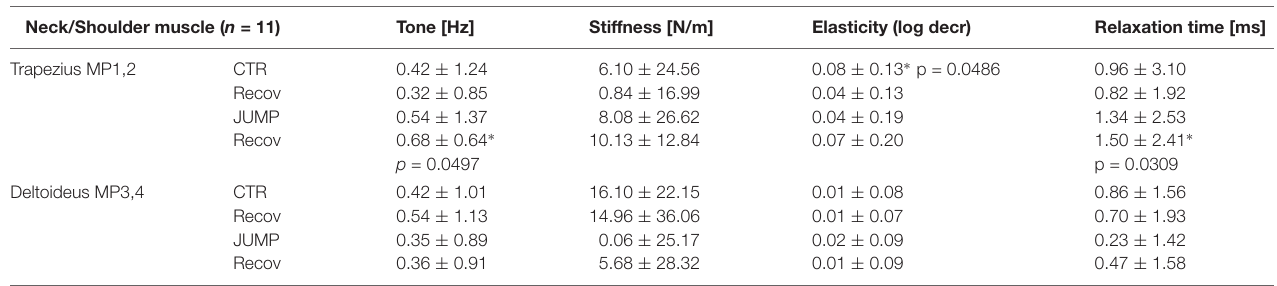
Biomechanical data collected from neck and shoulder muscle skin measurement points (Trapezius MP1,2 and Deltoideus MP3,4) in bed rest (HDT + 59 vs. HDT + 1) and recovery (R + 10 vs. HDT + 59) in both groups (CTR and JUMP). No significant changes in either parameters tested found in supine bed rest. ∗ Note parameter value changes [Hz, ms] in trapezius (p < 0.05) following return to daily life after 10 days (R + 10) of reconditioning (recov). Values are parameter value changes ± SD.